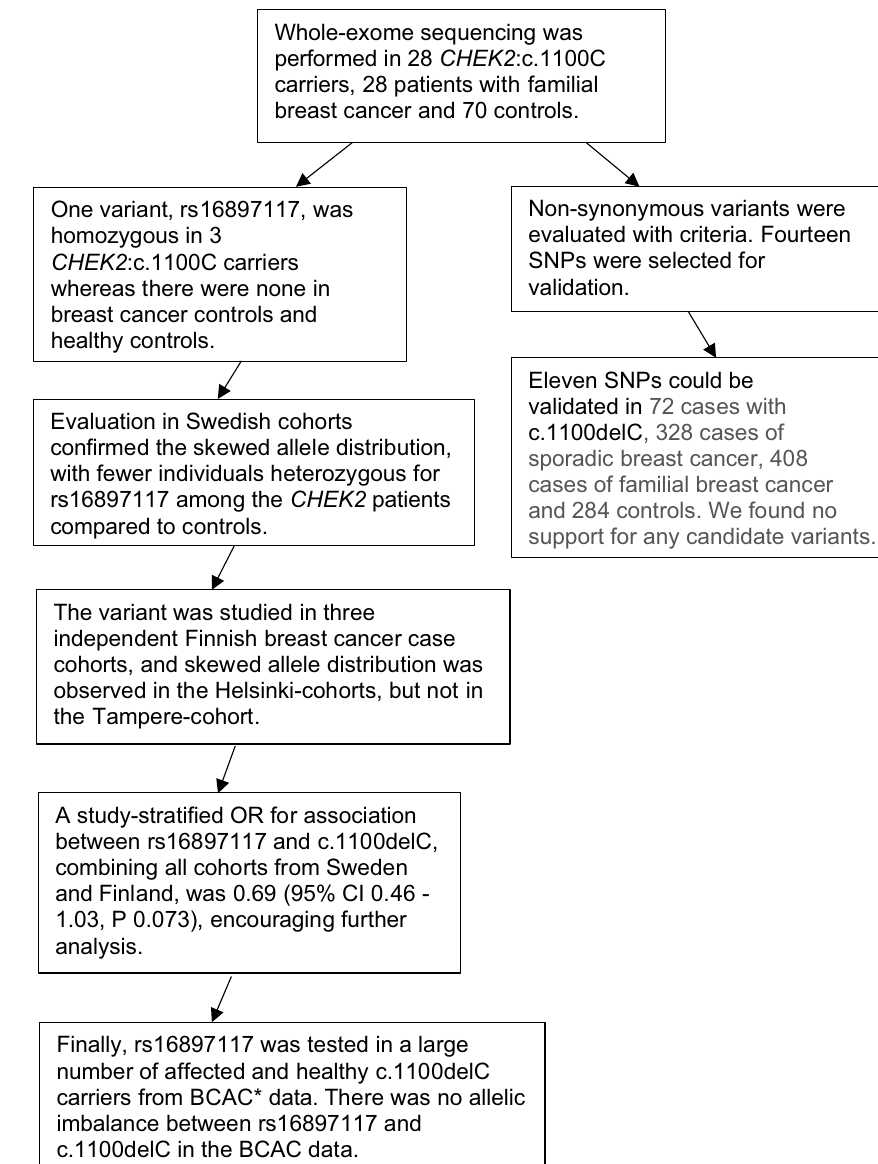
Figure 1. Flowchart describing the working process of evaluating genotype data in search of variants that specifically modify breast cancer risk in CHEK2 :c.1100del carriers. *Breast Cancer Association